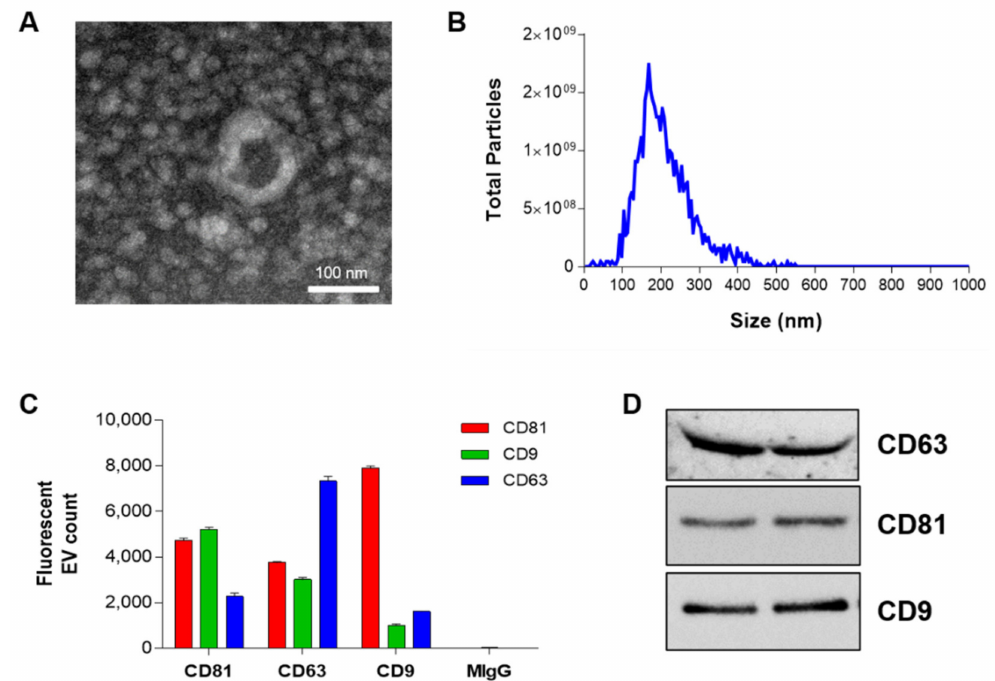
Figure 2. Characterization of EVs. ( A ) Evaluation of morphology by TEM. Scale bars = 100 nm. ( B ) Averaged NTA- determined size distributions. ( C ) ExoView shows the expression of CD9, CD63, and CD81 in MSC-derived EVs. ( D ) Western blot analysis of the exosomal surface